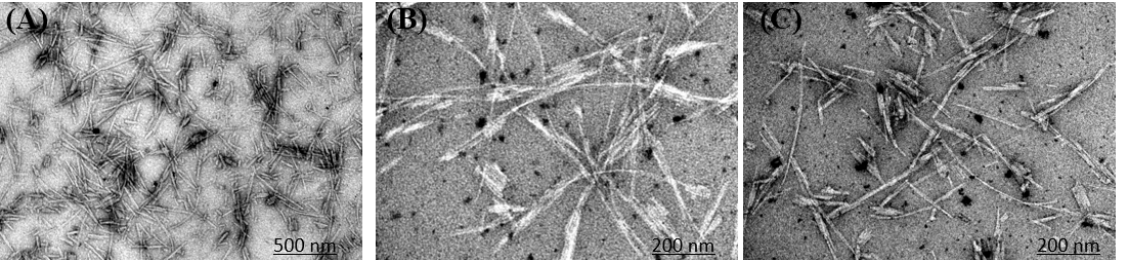
Figure 8. TEM analysis of HEWL fibrils in the absence and presence of CTZ. ( A ) HEWL fibrils. ( B ) HEWL fibrils in presence of 10 µM of CTZ. ( C ) HEWL fibrils in presence of 100 µM of CTZ. ( B ) HEWL fibrils in presence of 10 µ M of CTZ. ( C ) HEWL fibrils in presence of 100 µ M of